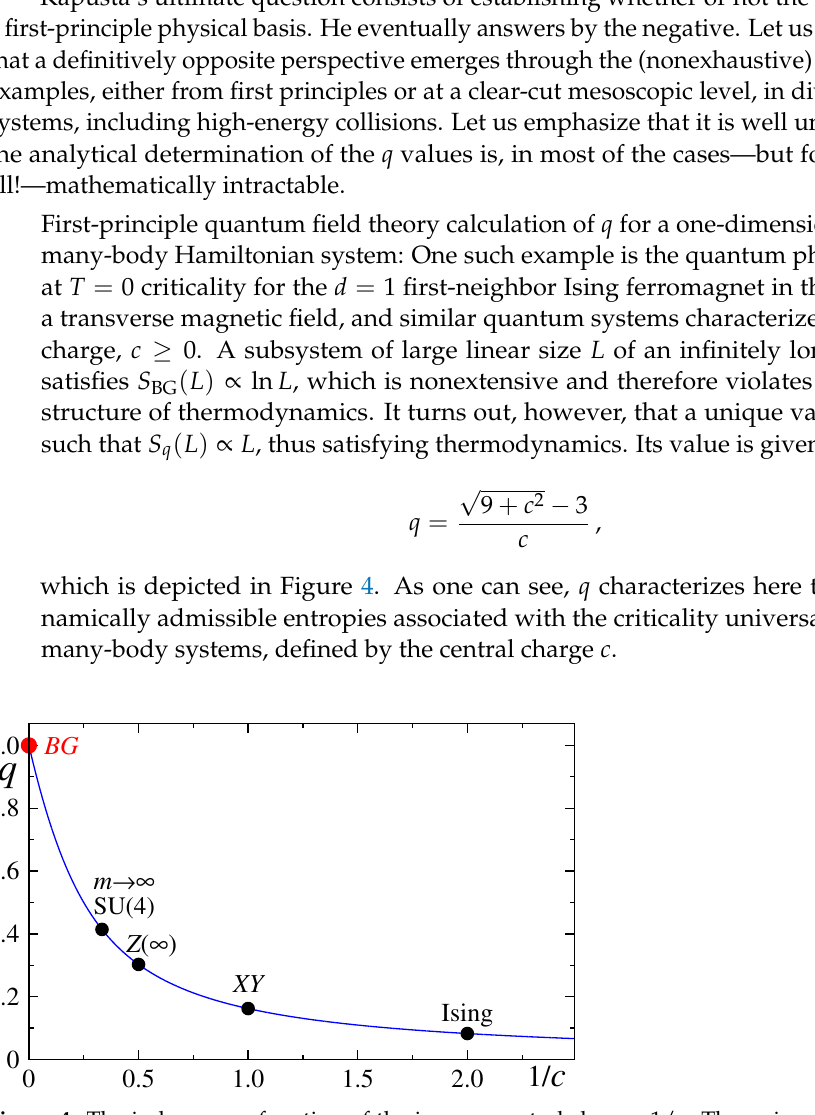
Figure 4. The index q as a function of the inverse central charge, 1/ c . The universality classes of some specific models are indicated; for example, c = 1/2 corresponds to the universality class of the short-range finite-spin Ising ferromagnet in the presence of a (critical) transverse field, at temperature T = 0. The Boltzmann–Gibbs value q = 1 is recovered in the c → ∞ limit. Taken from